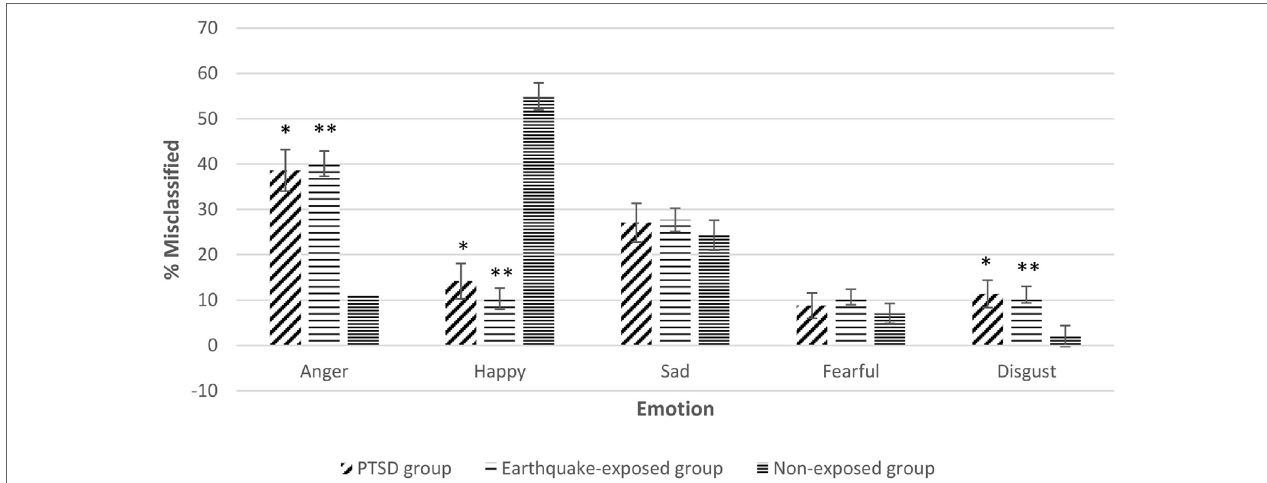
FigUre 2 | Gender, years of education, and age-adjusted misclassification of neutral expression to different emotions in the three groups. Pairwise comparisons significantly different p < 0.05. *Posttraumatic stress disorder (PTSD) group significantly different from non-exposed group. **Earthquake-exposed group significantly different from non-exposed